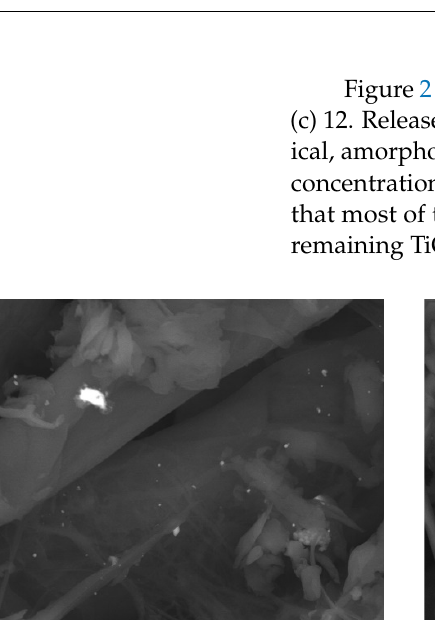
5 of 11 Figure 1. ATR-FTIR spectra of paint dust generated by sanding using P120 sandpaper after 0, 3, and 12 months of environmental weathering.